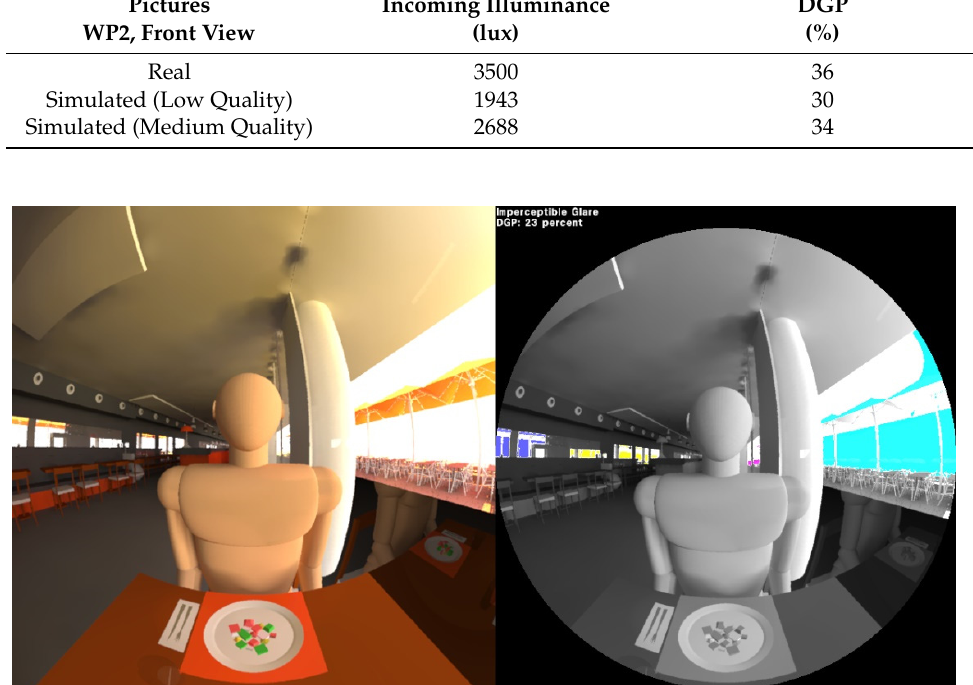
Figure 5. Changing the pavement glaring surface color, the results of visualization, DGP results and glare source image. The change was from clear grey (R, 0.35; G, 0.35; B, 0.35) pavement to black dark (R, 0; G, 0; B, 0) pavement.